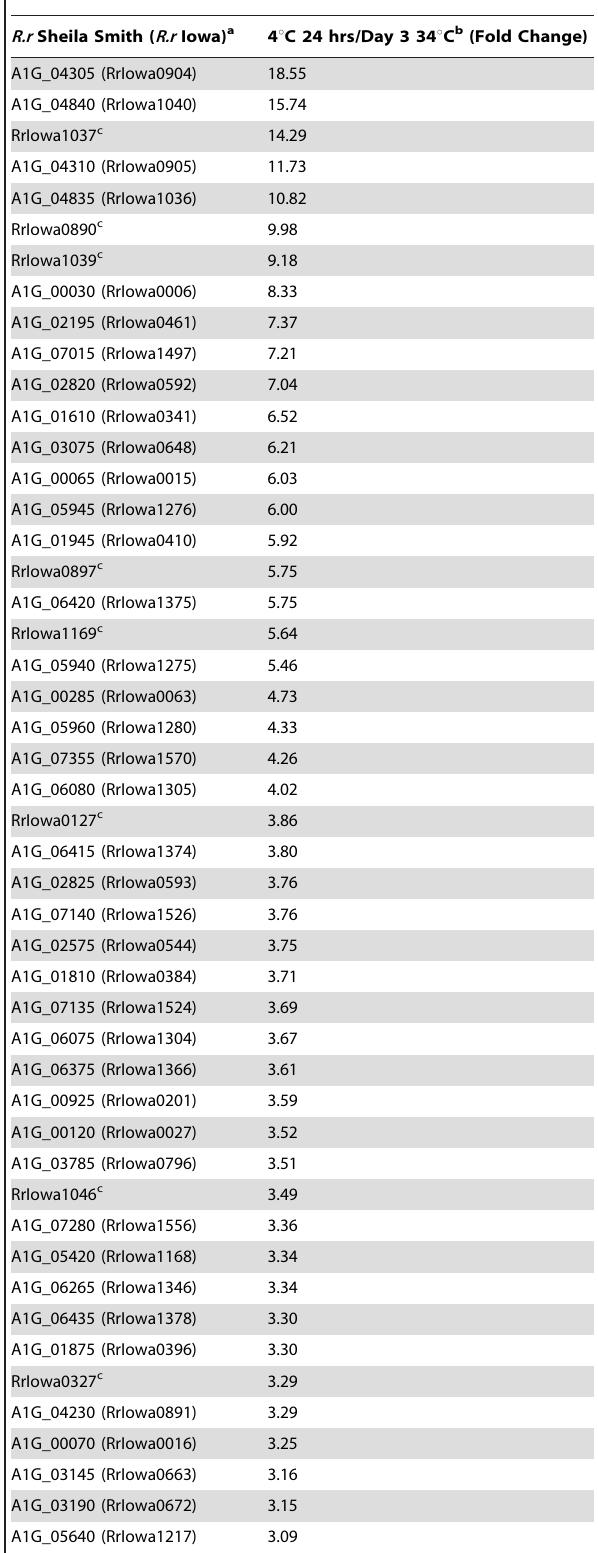
Table 2. Transcriptional response of R. rickettsii exposed to 4 u C for 24 hrs.